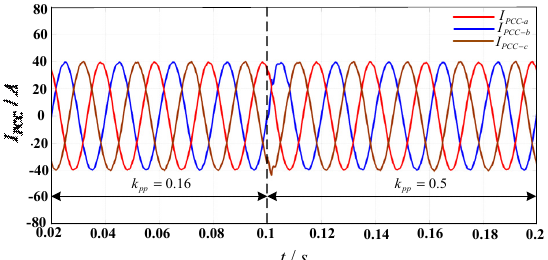
Figure 20. Simulation result of current waveform at PCC after reshaping when the proportional coefficient of PLL changes.